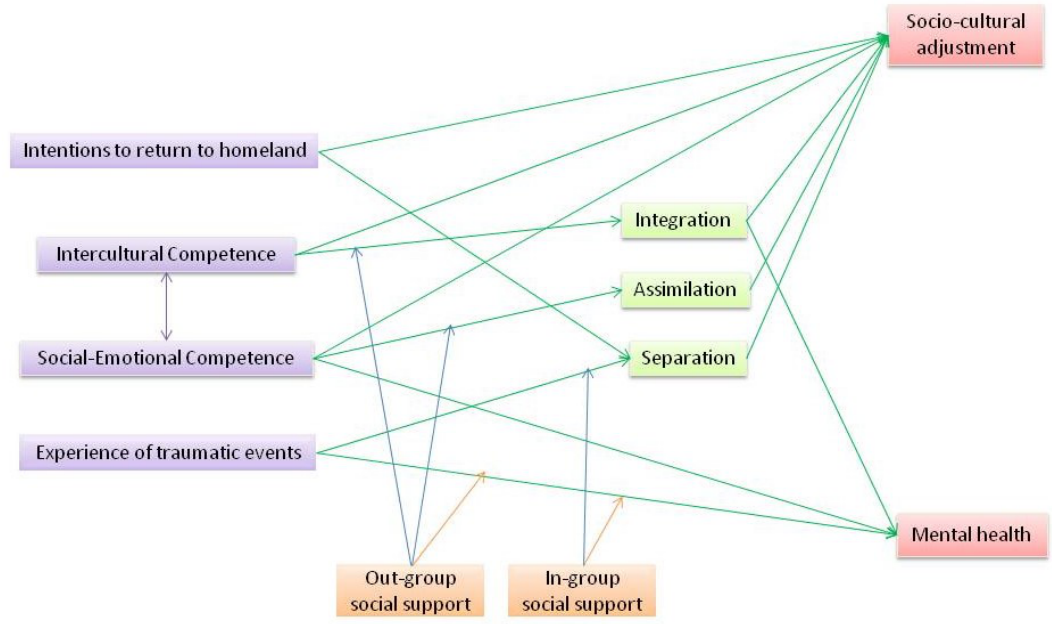
Figure 1. Multidimensional Intercultural Training Acculturation Model (MITA).